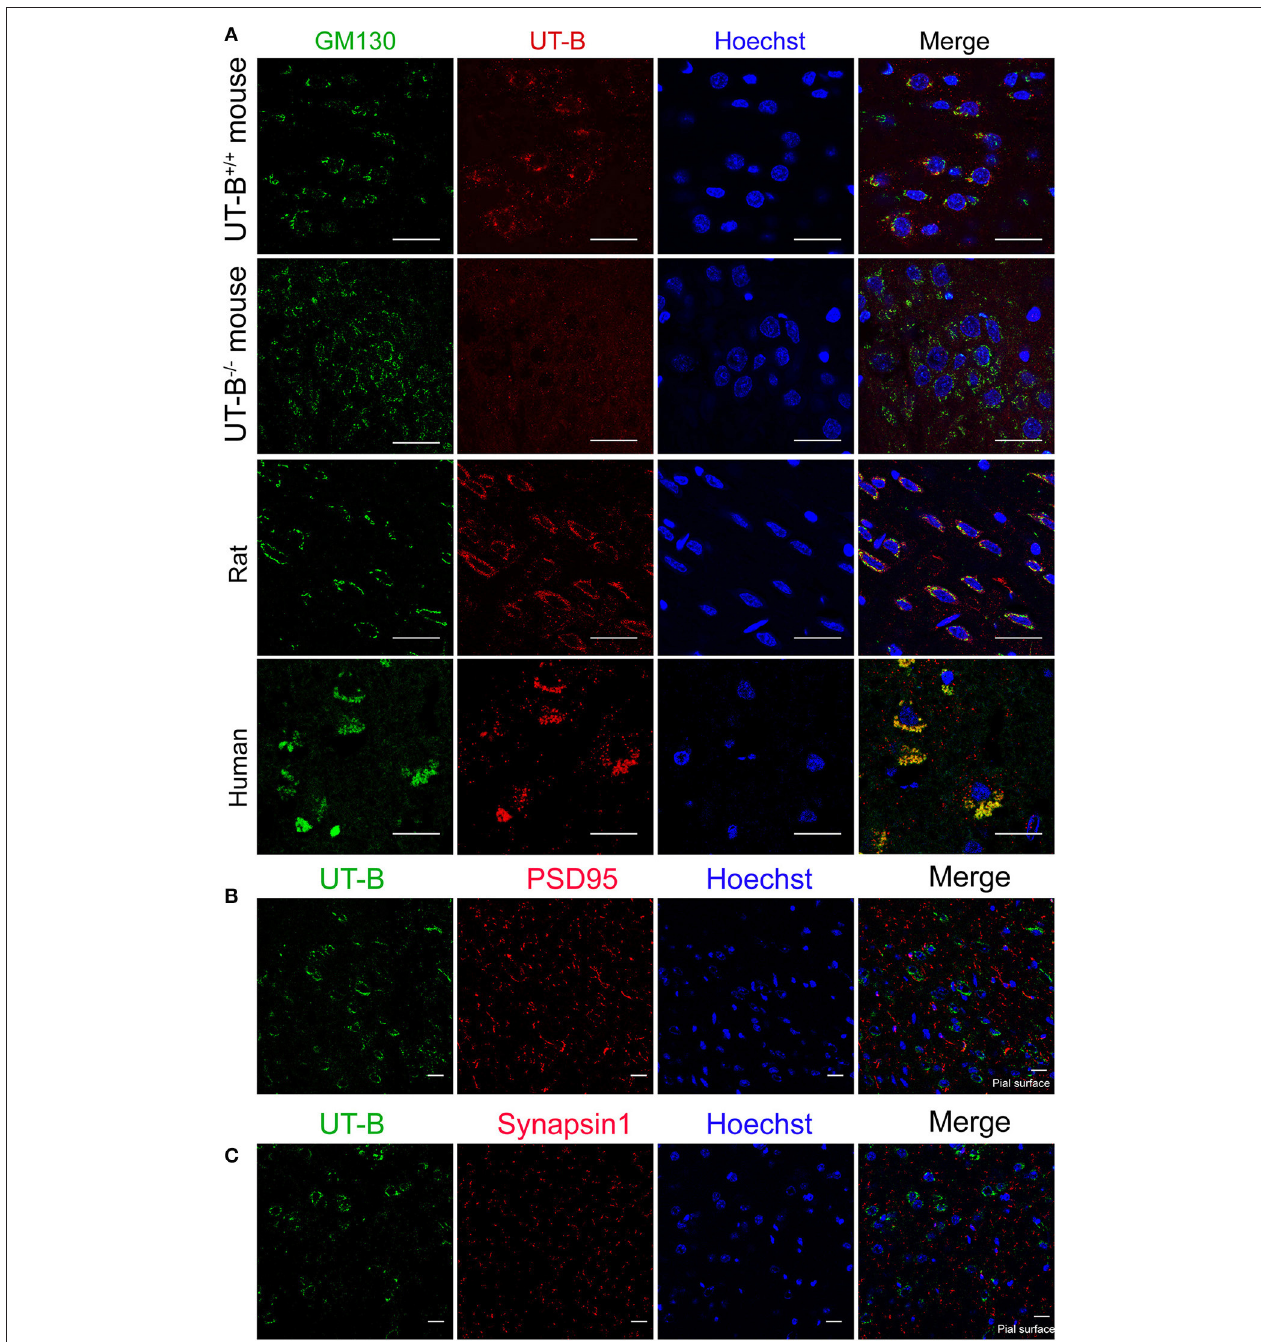
FIGURE 5 | UT-B is located on the Golgi apparatus in normal circumstances. (A) Representative immunofluorescence images of wild-type rats, wild-type mice, UT-B knockout mice, and human cerebral cortex revealed colocalization of UT-B (red) and GM130 (green). Nuclei were stained blue with Hoechst. (B) Co-stained immunofluorescence images of UT-B (green) and postsynaptic membrane marker PSD95 (red) in the cerebral cortex of wild-type mice. (C) Co-stained immunofluorescence images of UT-B (green) and synaptic marker synapsin 1(red) in the cerebral cortex of wild-type mice. The pial surface is located in the lower right corner of the image. The images of b and c mainly show the internal granule cell layer and the internal pyramidal cell layer. Scale bar, 50 µ m. UT-B, urea transporter B.